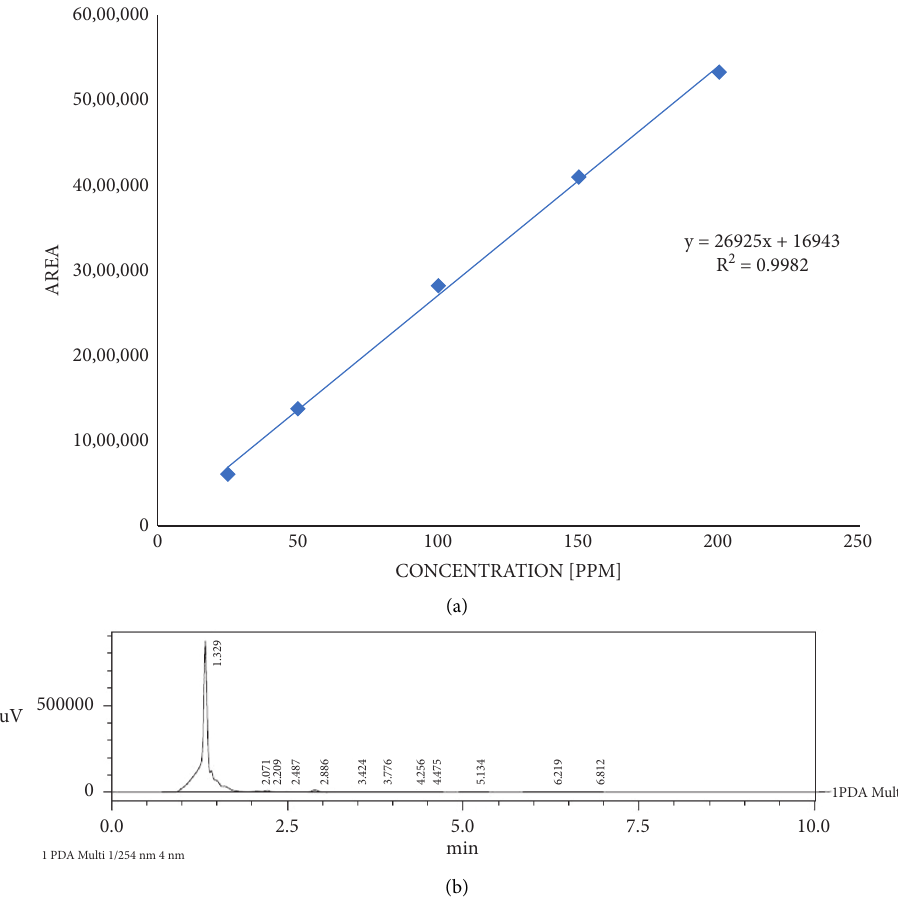
Figure 1: Standard ellagic acid concentration 200ppm (a) and standard curves of pure ellagic acid of various concentrations